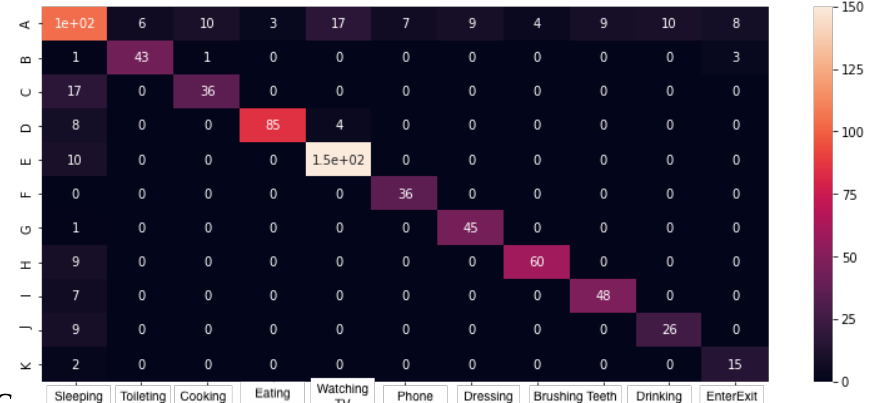
Figure 7. Confusion matrix for the best classifiers. ( A ) SVM + [ t + , t − ] = [ 0,1 ] in the baseline, ( B ) KNN + [ t + , t − ] = [ 2,4 ] with fuzzy spatial features, and ( C ) KNN + [ t + , t − ] = [ 8,15 ] with fuzzy spatial temporal features.